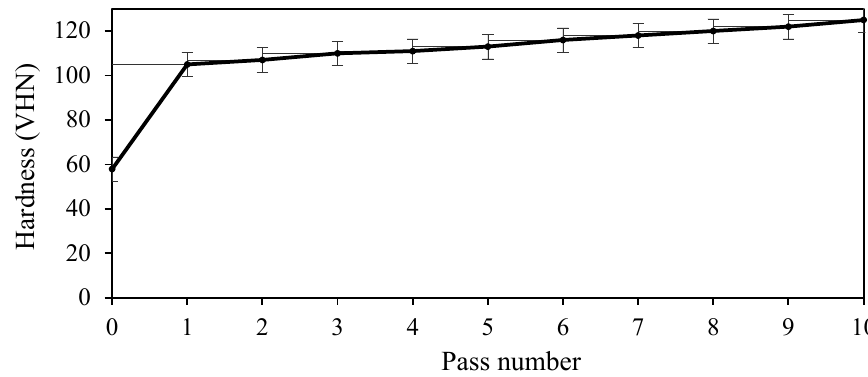
Figure 14. Hardness of modified ‐ CSP samples in terms of number of passes.